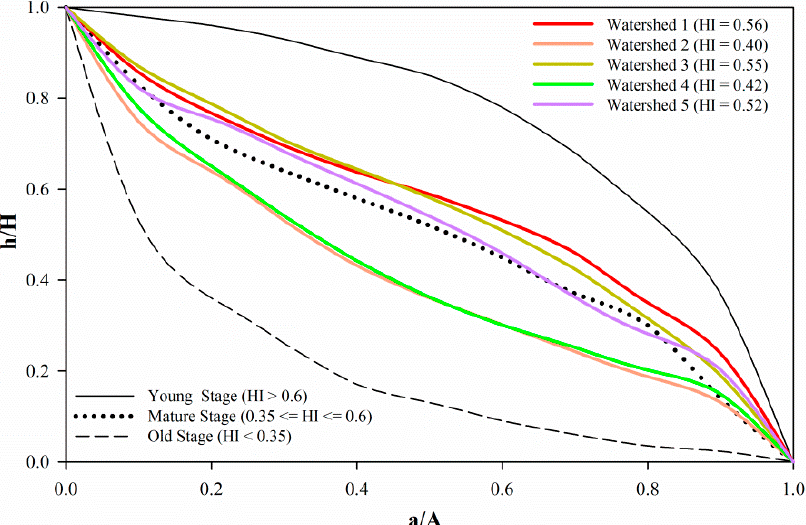
Figure 7. Hypsometric integral curve. The black line represents the three stages of the development of the watershed geomorphology.